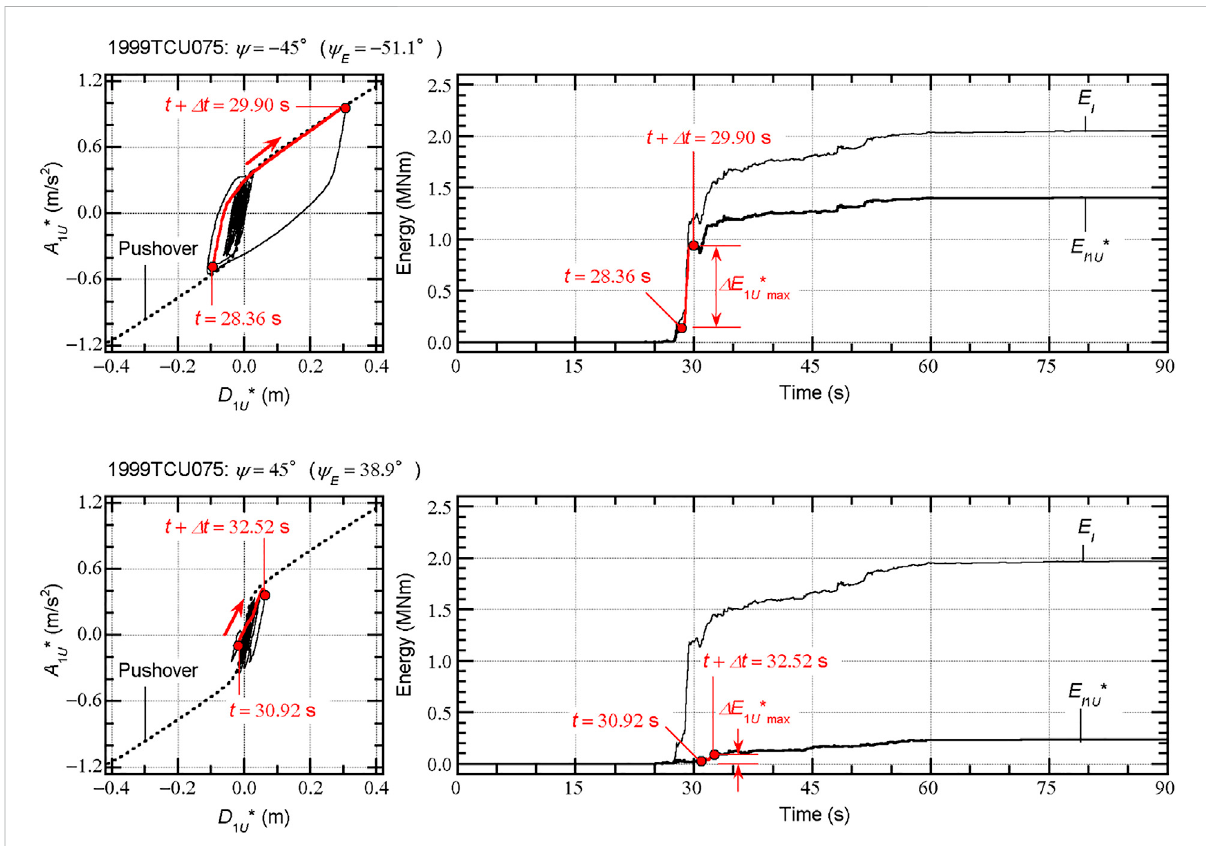
FIGURE 12 Hysteresis of the fi rst modal response and the time-history of the energy input.